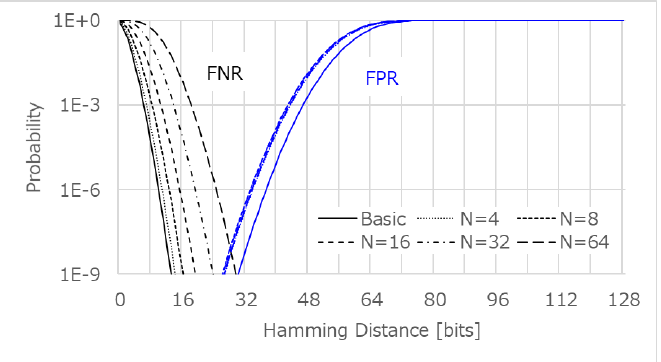
Figure 9. Estimated FNR and FPR estimated from the intra-HD and